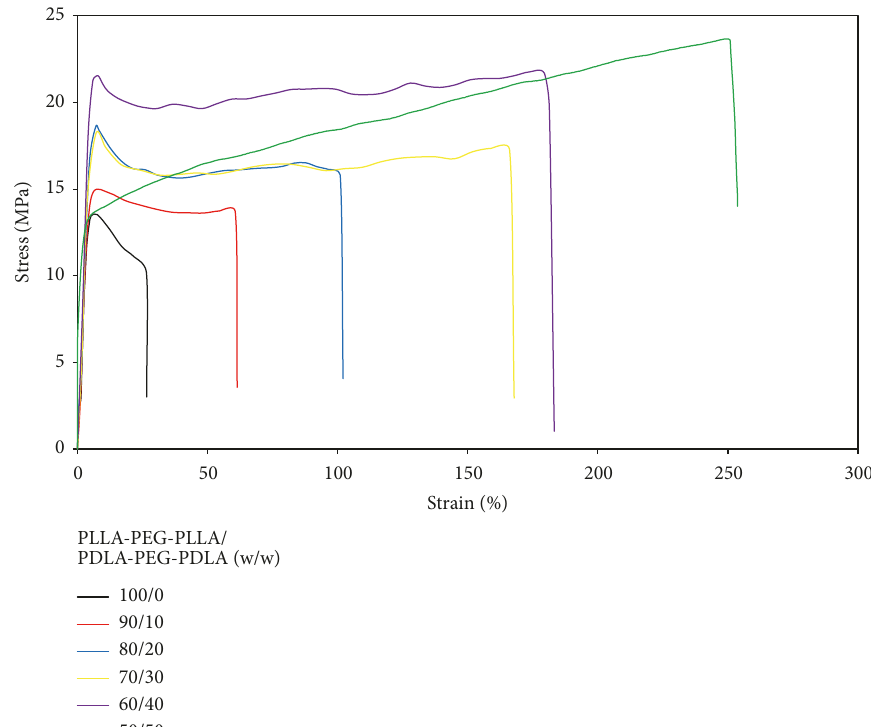
Figure 4: Tensile curves of PLLA-PEG-PLLA/PDLA-PEG-PDLA blend films.